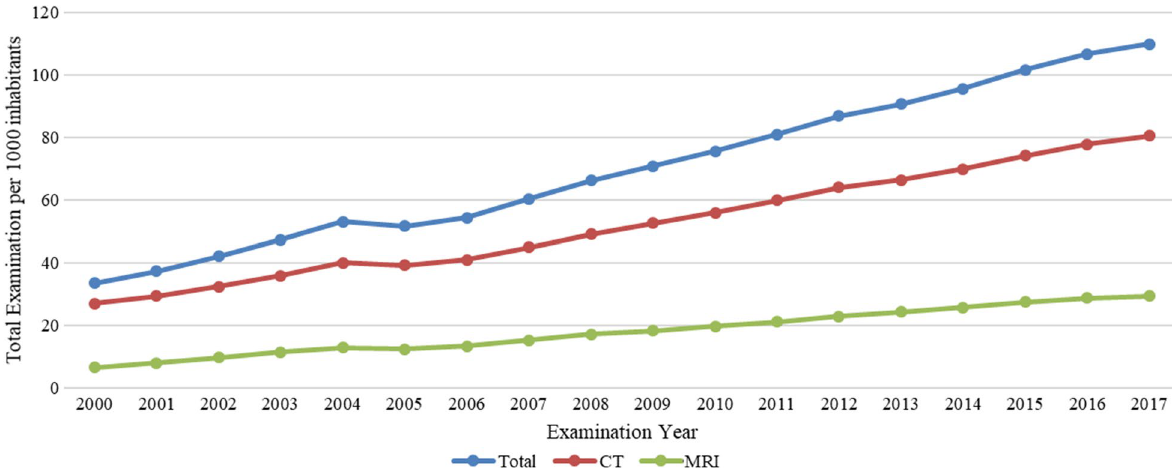
Fig. 3 Annual numbers of medical imaging examinations performed in Taiwan from 2000 to 2017 (per 1000 inhabitants)